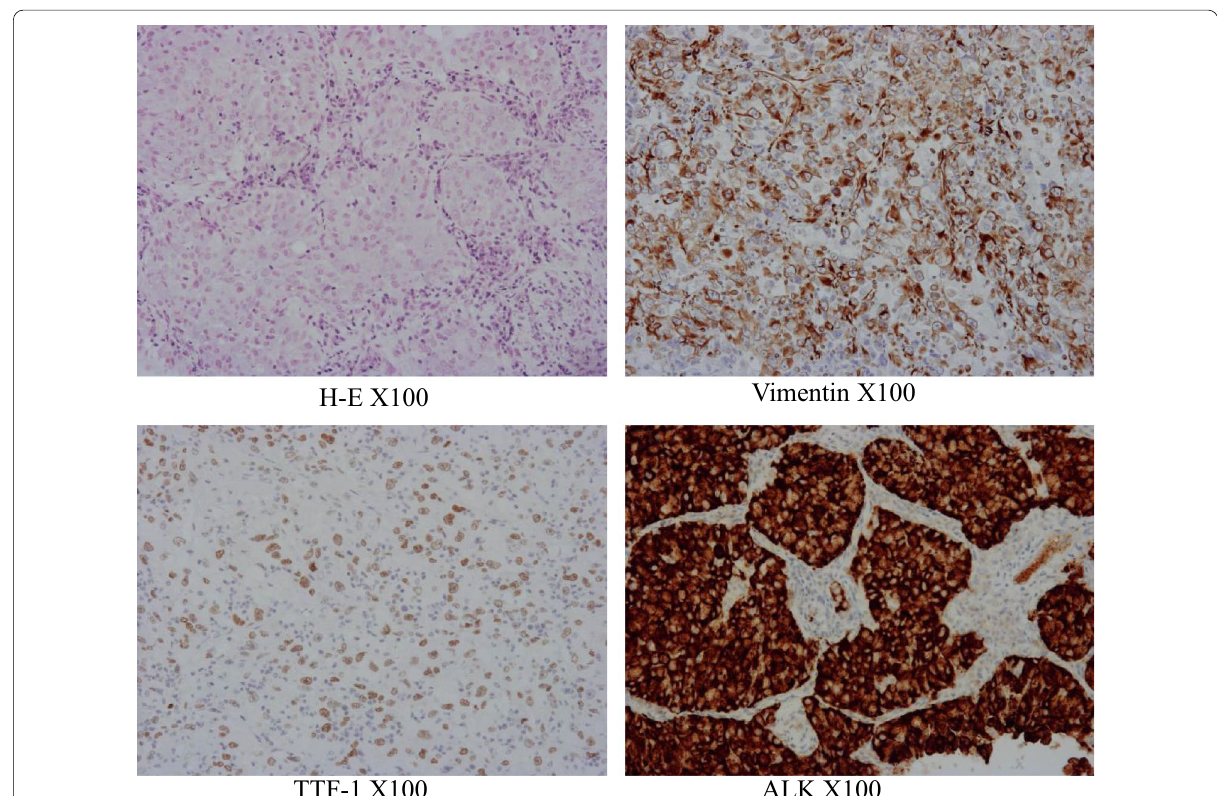
Fig. 3 Microscopic findings of the tumor indicated pleomorphic carcinoma with adenocarcinoma features. a Hematoxylin and eosin staining ( 200). b TTF-1 immunostaining. c Vimentin immunostaining. d ALK immunostaining. TTF-1 thyroid transcription factor-1, ALK anaplastic × lymphoma